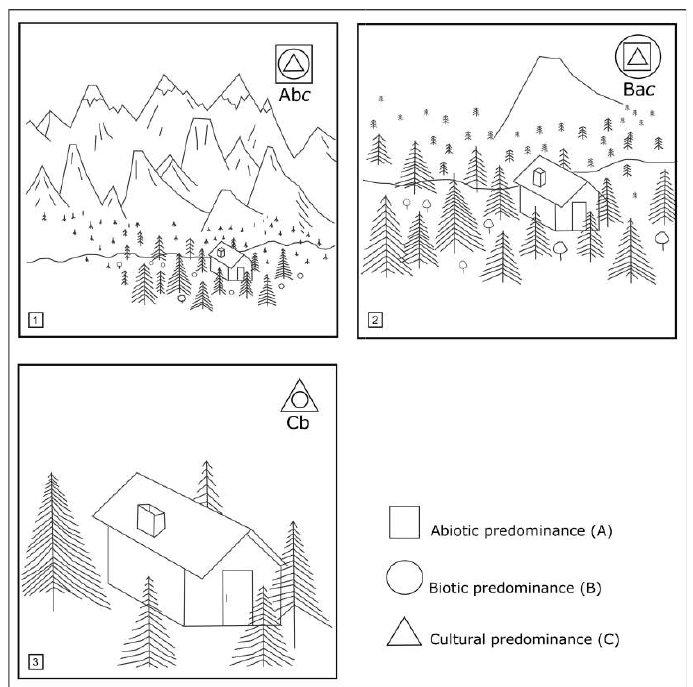
Figure 1: One didactic application for the ABC method uses shapes and letters to characterise the landscape through its main components: A stands for abiotic predominance of elements and it is represented by a square, B stands for biotic and it is represented by a circle, and C for cultural and by a triangle; principal predominance (>50%) is shown in capital letters, secondary predominance (50%-20%) in lower case letters, and significant presence (<20%) in italics. In 1 a landscape is represented at a broad scale and the abiotic predominance is main, followed by biotic and a bit of cultural (Abc); in 2 the same landscape is shown at a medium scale, and at this level biotic elements are predominant followed by cultural ones and a significant abiotic presence (Bac); in 3 a view of the same landscape is shown at a detailed level, and cultural elements are predominant followed by biotic whereas abiotic elements are negligible (Cb). Source: modified from Bolòs